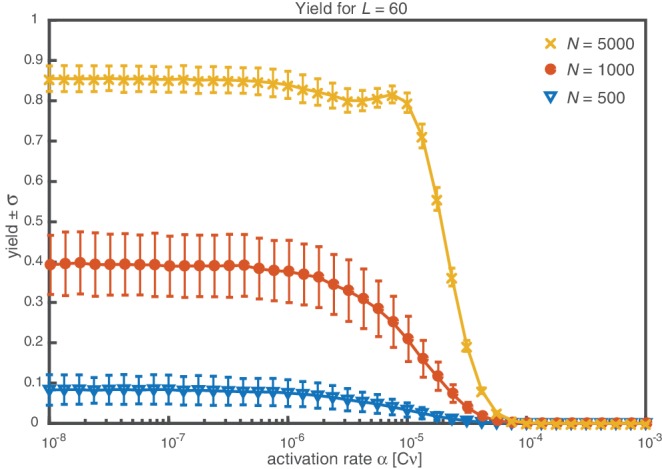
Average yield and its sample standard deviation.For average yield close to 0 or close to 1, the standard deviation has to be small due to the boundedness of the yield to the interval [0, 1]. For intermediate values, the standard deviation is highest. Its value is, however, still considerably smaller than the average yield. The parameters are L= 60, S=L, μ=ν=1 and different particle numbers N (colors/symbols). To obtain the average yield, the yield has been averaged over 1000 simulations. The standard deviation corresponds to the unbiased sample standard deviation.